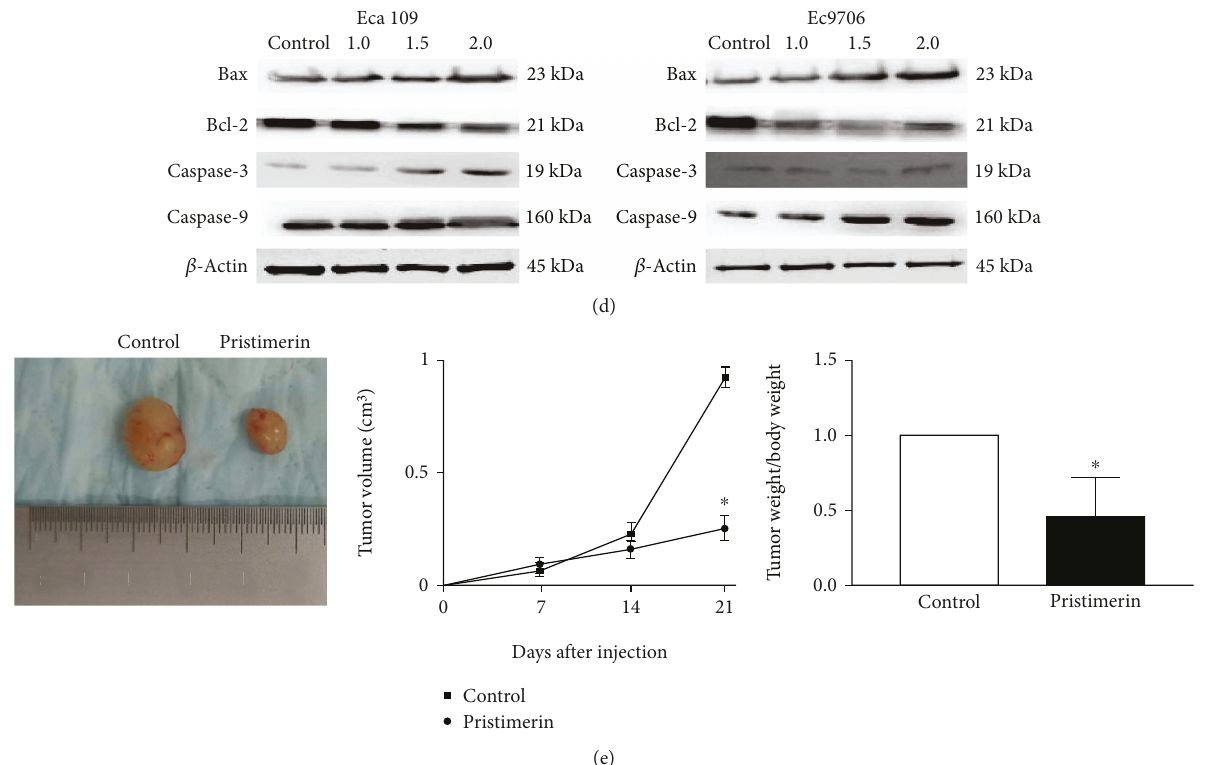
Figure 1: Pristimerin inhibits human esophageal cancer cell proliferation. (a) Molecular formula of pristimerin. (b) Eca109 and Ec9706 cells were treated with pristimerin at concentrations of 0.5, 1.0, 1.5, 2.0, and 4.0 μ mol · L – 1 for 48 h. Relative cell viability determined by the CCK-8 assay. (c) Cytometric analysis of Eca109 and Ec9706 cells treated with pristimerin (0.5, 1.0, 1.5, 2.0, and 4.0 μ mol · L – 1 , 48 hours). (d) Protein level of Bcl-2, Bax, caspase-3, and caspase-9. (e) E ff ect of pristimerin on the growth of Eca109 cells injected into nude mice. Male BALB/c nude mice were subcutaneously injected with 5 × 10 6 Eca109 cells infected with pristimerin. Tumor volume and weight were monitored over time as indicated, and the tumor was excised and weighed after 21 days. ∗ P < 0 05 versus control group. n = 3 independent experiments for each